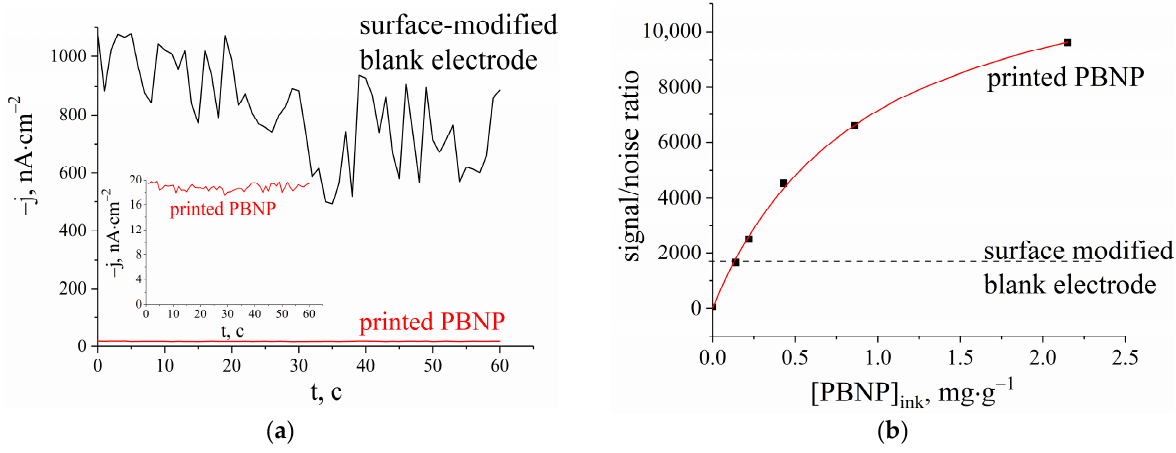
Figure 3. ( a ) The background and noise level for surface-modified blank electrodes (black line) and electrodes with printed Prussian blue nanoparticles (PBNP) (red line and inset); ( b ) signal-to-noise ratio dependance on Prussian blue nanoparticle concentration in carbon/graphite paste.